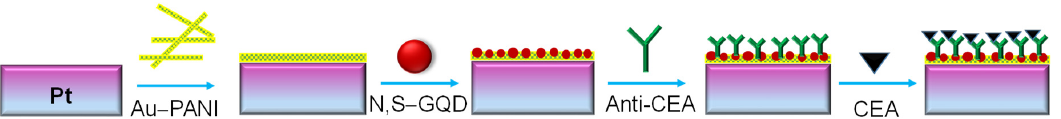
Figure 26. A label-free impedimetric sensing system for CEA. Adapted from Mansuriya and Altintas [79].